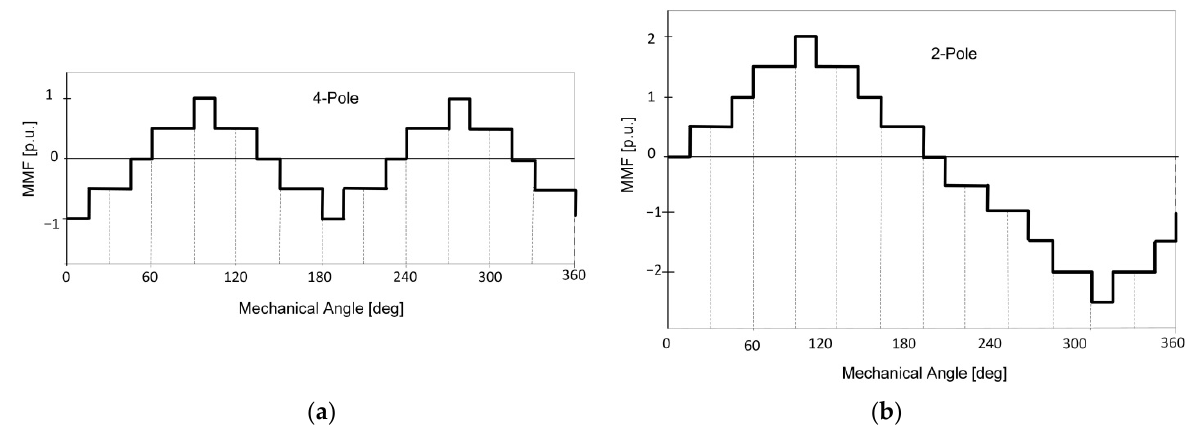
Figure 7. MMF distribution of multi-winding IM in space for two pole pairs p = 4 ( a ) and for one pole pair p = 2 ( b ).